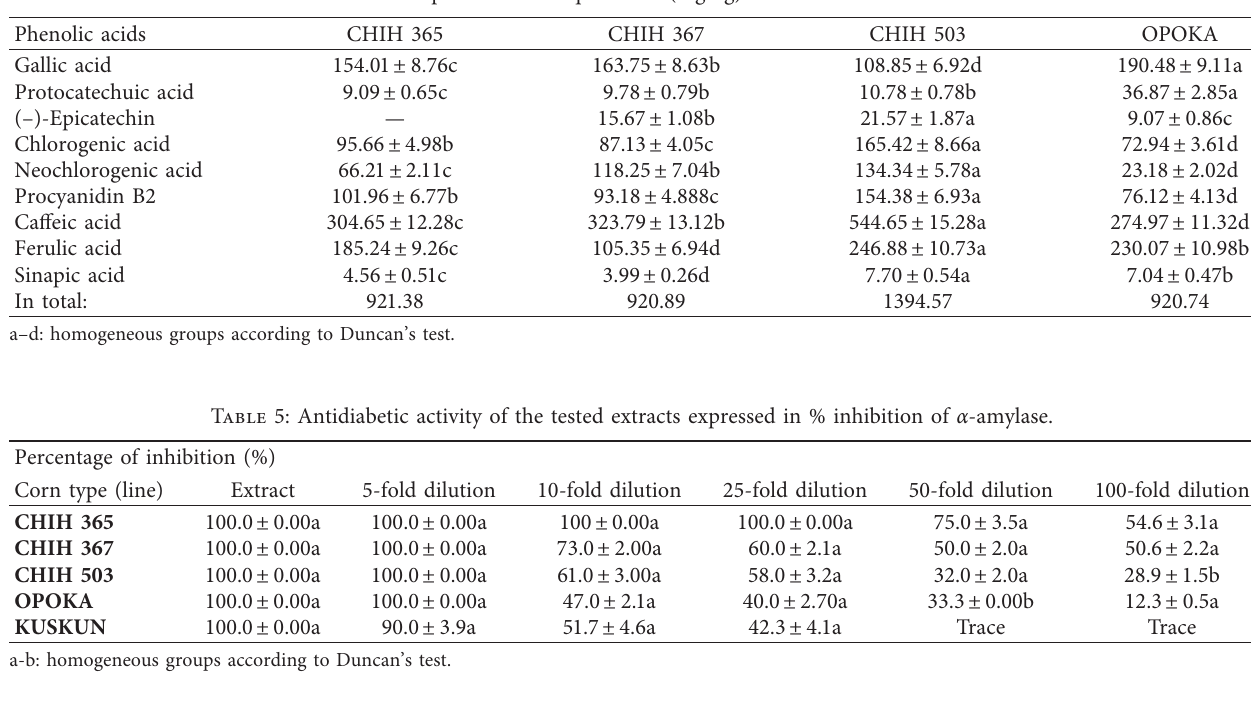
Table 4: Profile of phenolic acids quantified (mg/kg) in the tested maize varieties.